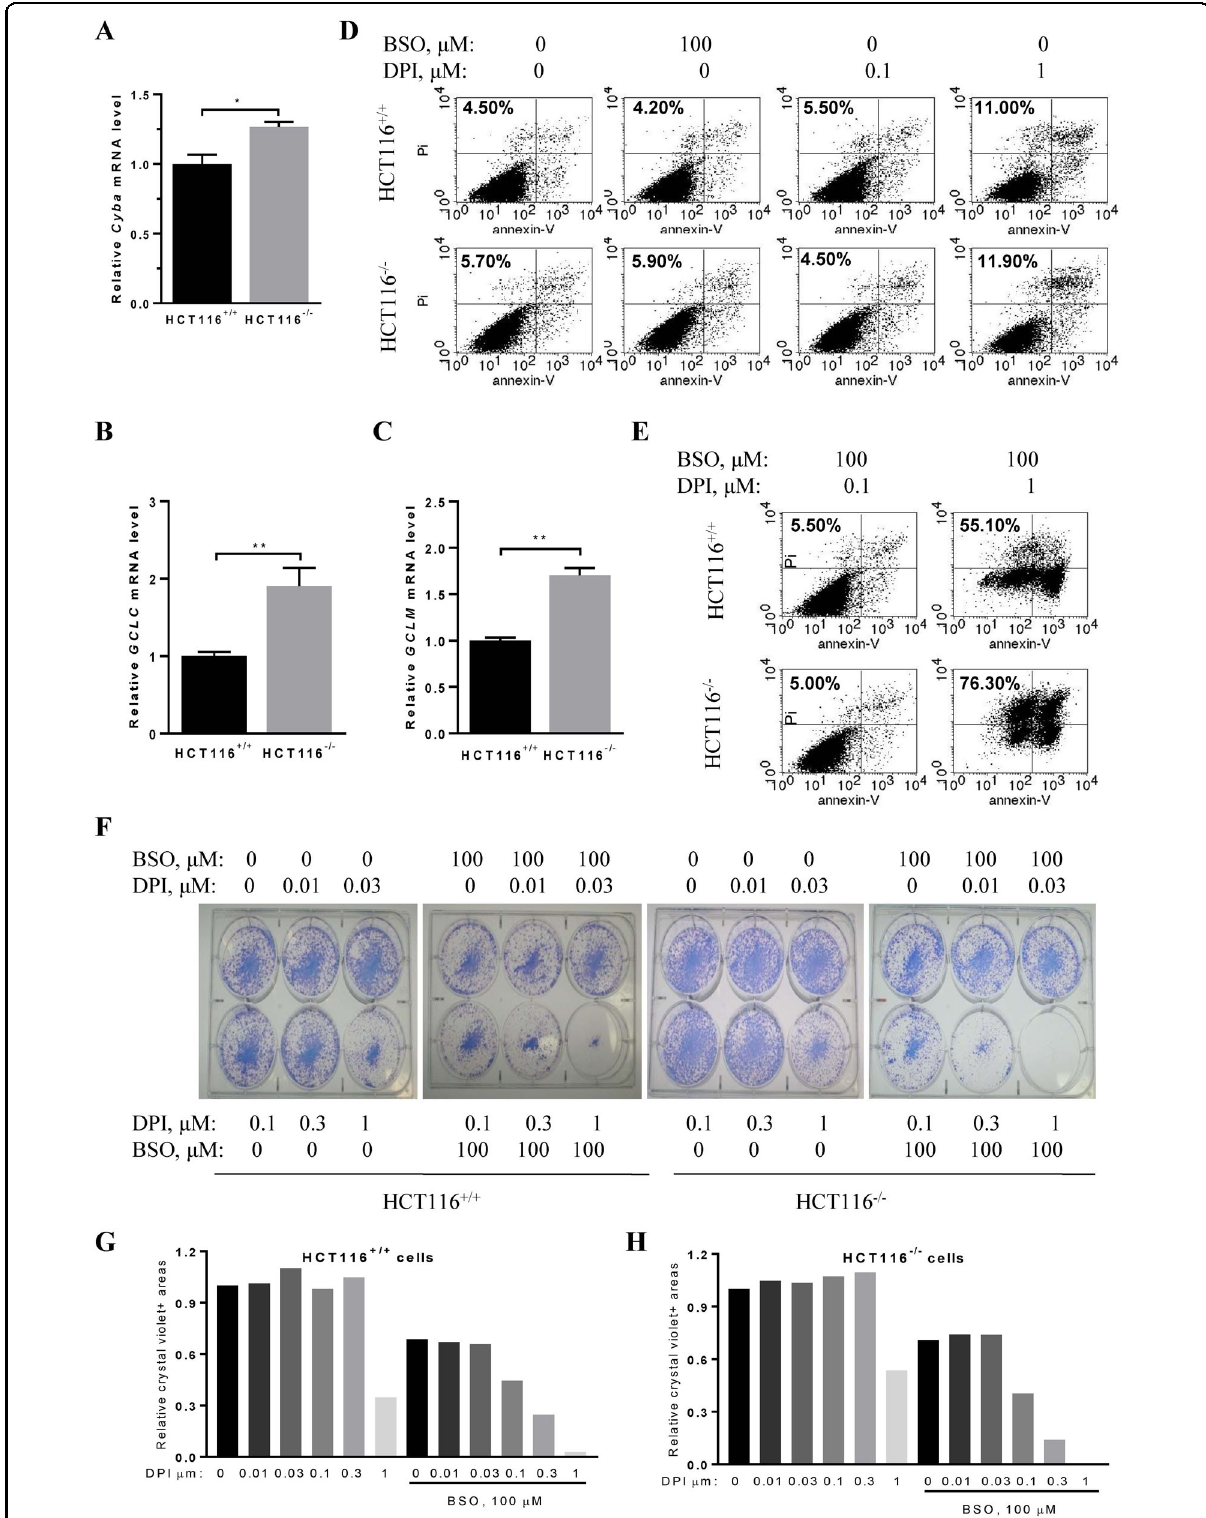
Fig. 3 (See legend on next